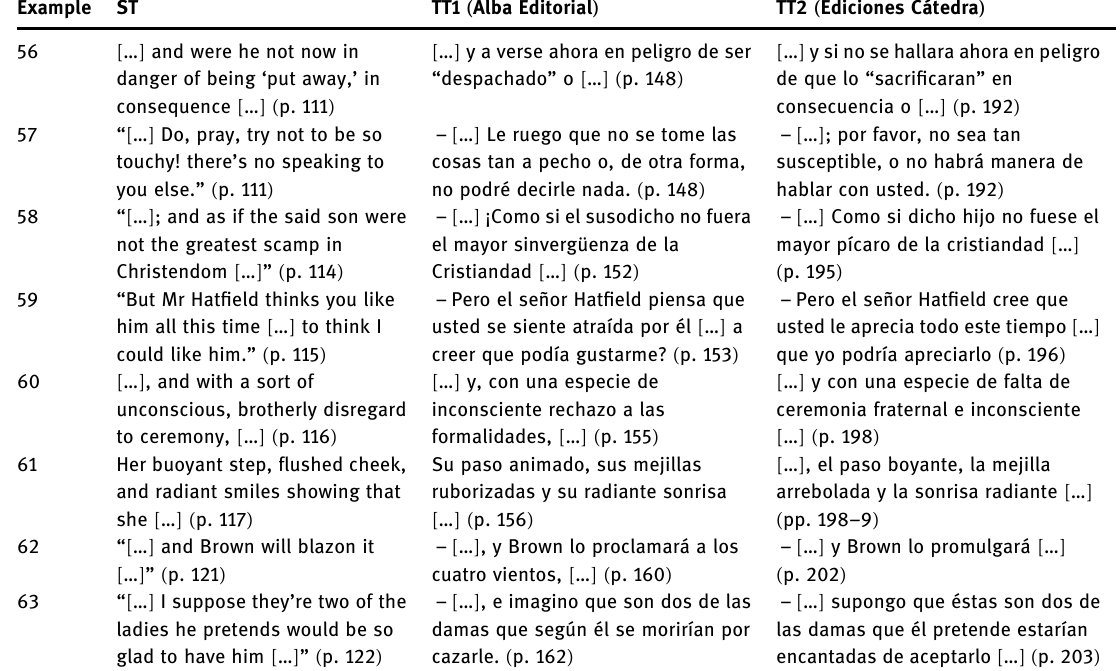
Table 12: Examples taken from Chapter 14 Example ST